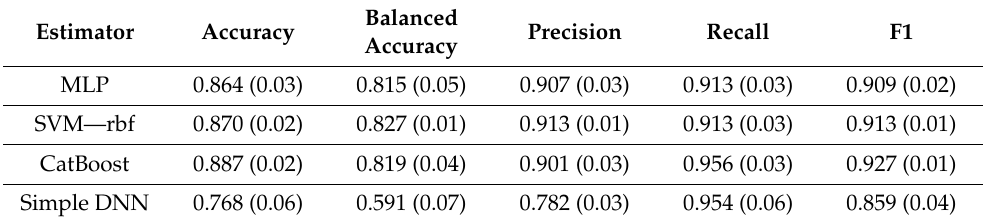
Table 4. Performances for classification task 1: separate PD from healthy. Values correspond to mean (SD). MLP = multi-layer perceptron, SVM—rbf = support vector machine—radial basis function, simple DNN = simple deep neural network.